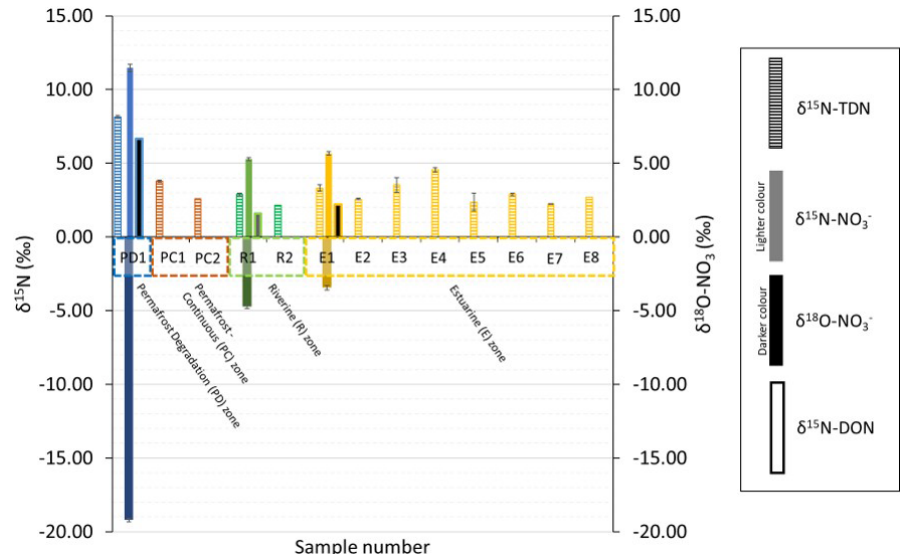
Figure 4. Nitrogen isotopes of TDN, nitrate (NO − ), and DON in different zones of the lower Kolyma River, as overviewed in Fig. 1a. Oxygen 3 isotopes ( δ 18 O) of nitrate are also shown on the negative scale below the nitrogen isotope values. Only three sites (PD1, R1, and R2) were able to have nitrogen isotopes of nitrate (and therefore also of DON) analysed, as most nitrate concentrations were < 1µM. However, since nitrate concentrations were very small in comparison to DON (see Fig. 3), especially for the permafrost influenced site, then it can be assumed that the nitrogen isotopic signature of DON is roughly equal to the signature of TDN ( δ 15 N-DON ≈ δ 15 N-TDN). The permafrost-influenced sample was analysed across four repeat runs, allowing a robust standard deviation to be